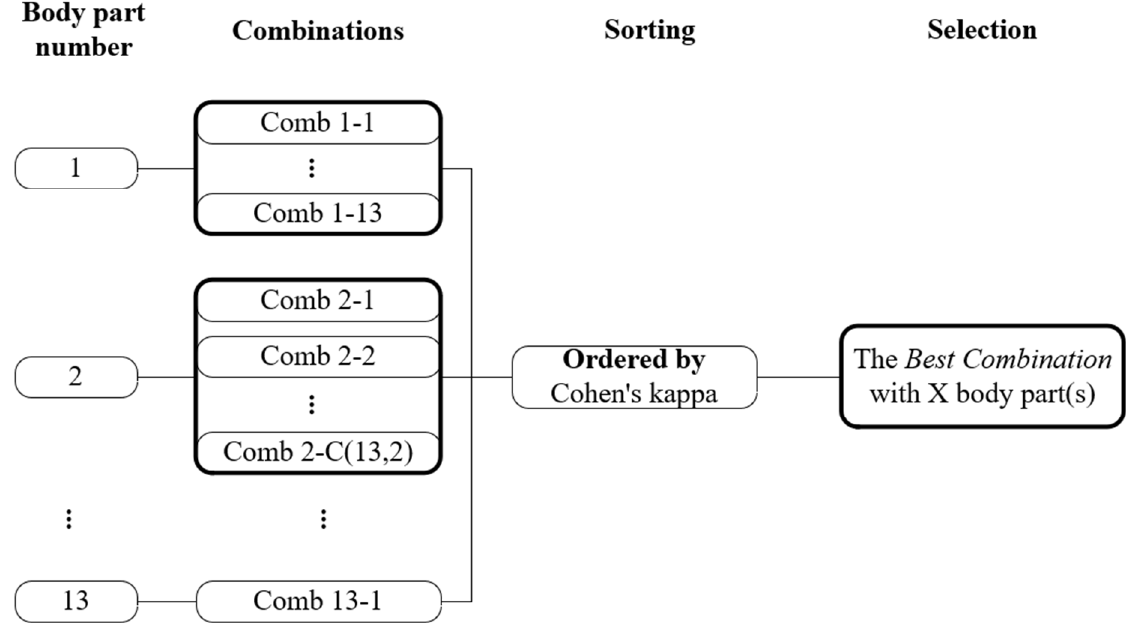
Figure 2. The method of selection for the best combination .